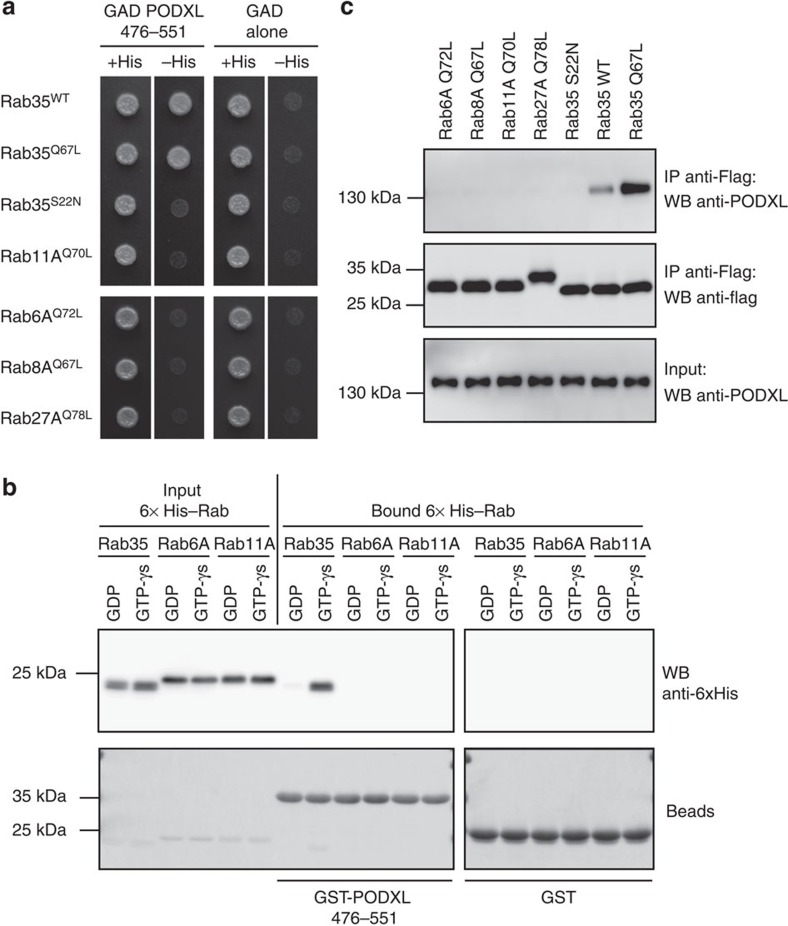
GTP-bound Rab35 directly interacts with PODXL.(a) Saccharomyces cerevisiae L40 reporter strain was transformed with plasmids encoding GAD fused to PODXL cytoplasmic tail (aa 476–551) or GAD alone to examine interactions with LexA fused to Rab35WT, Rab35Q67L (GTP-bound mutant), Rab35S22N (GDP-bound mutant), Rab11AQ70L (GTP-bound mutant), Rab6AQ72L (GTP-bound mutant), Rab8AQ67L (GTP-bound mutant) and Rab27AQ78L (GTP-bound mutant). Growth on a medium without histidine (−His) indicates an interaction with the corresponding proteins in this two-hybrid assay. (b) Recombinant GST or GST–PODXL (aa 476–551) immobilized on glutathione beads was incubated with recombinant 6xHis-tagged Rab35WT, Rab11AWT or Rab6AWT, and loaded with either GDP or GTPγS. Top panel: Rab proteins directly bound to beads were detected by western blot with anti-6xHis antibodies. 5% of the Rab protein input are displayed in the first six lanes. Bottom panel: bead inputs in Ponceau staining. (c) Rab proteins were immunoprecipitated with anti-Flag antibodies (IP) from MDCK cells transfected with plasmids encoding 3xFlag-tagged Rab6AQ72L, Rab8AQ67L, Rab27AQ78L, Rab11Q70L, Rab35S22N, Rab35WT or Rab35Q67L. Flag-proteins and co-immunoprecipitated endogenous PODXL were detected by western blot using anti-PODXL antibodies (top panel) and anti-Flag antibodies (middle panel). Corresponding inputs (5% of total lysates) are displayed in the bottom panel.